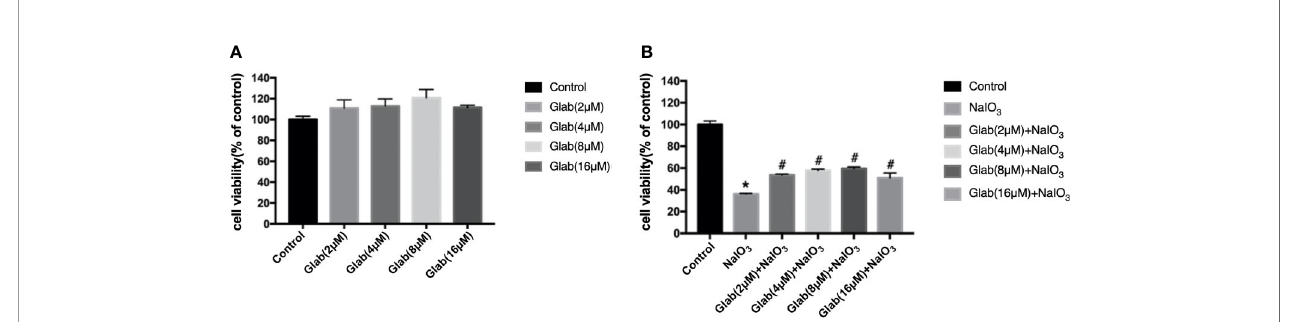
FIGURE 1 | Effects of Glabridin on the viability of ARPE ‐ 19 cells in vitro . (A) methylthiazolyldiphenyl ‐ tetrazolium bromide (MTT) assay showed that Glabridin had no toxic effects on ARPE ‐ 19 cells at concentrations of 2, 4, 8 m M. (B) MTT assay showed that Sodium iodate(NaIO 3 ) group, cells treated with NaIO 3 (1200 m g/ml), signi fi cantly decreased the viability of ARPE-19 cells compared with the control group (* P < 0.05) and Glabridin at concentrations of 2, 4, 8 m M signi fi cantly increased the viability of ARPE ‐ 19 cells treated with sodium iodate, compared with NaIO 3 group ( # P <